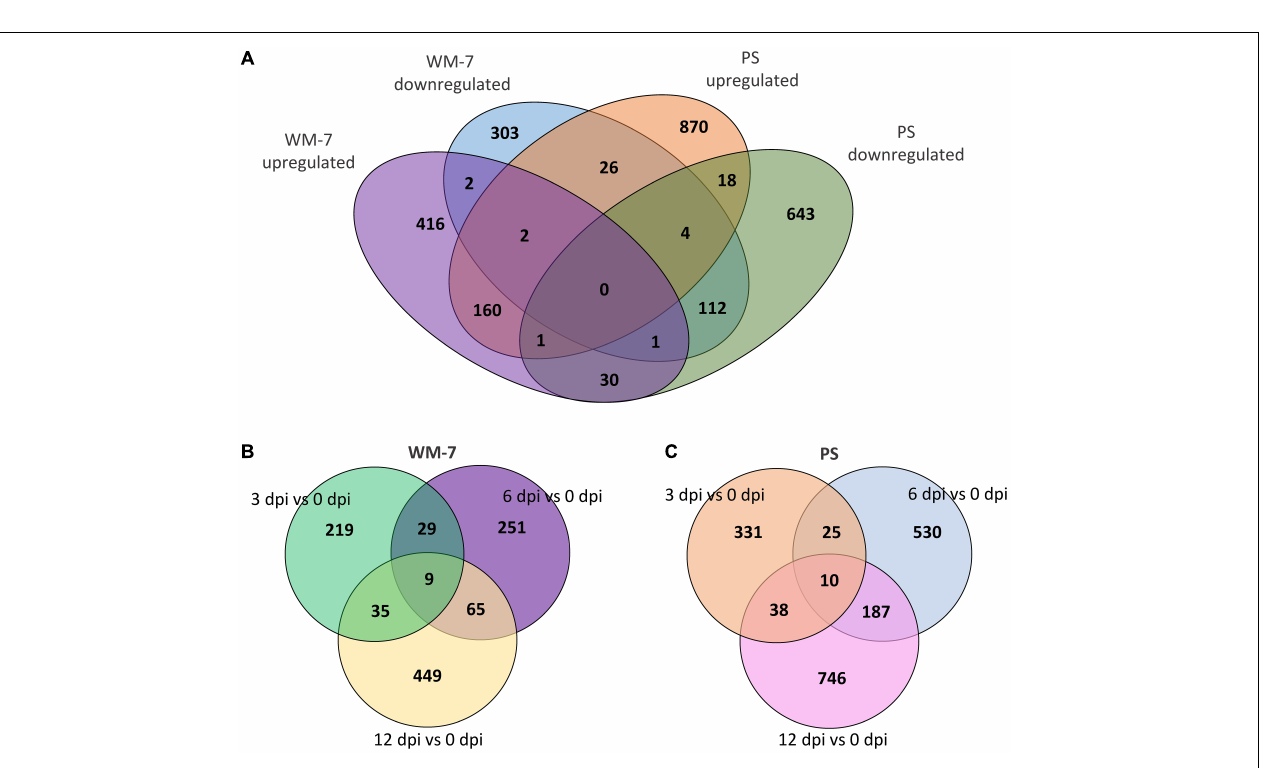
Frontiers in Plant Science |